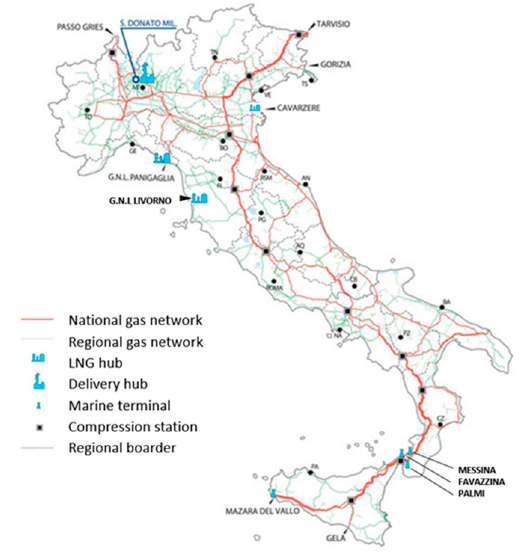
Figure 1. Italian national (red) and regional (blue) pipeline gas network. Injection points from foreign suppliers [24].